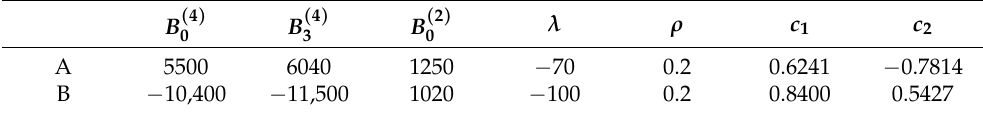
Table 1. Estimated parameters of energy operators in cm − 1